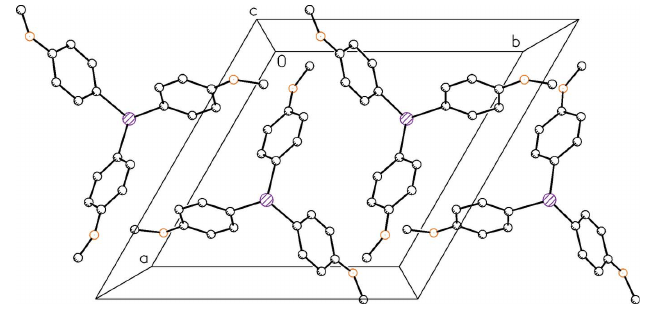
Figure 2 Packing diagram excluding hydrogen atoms.